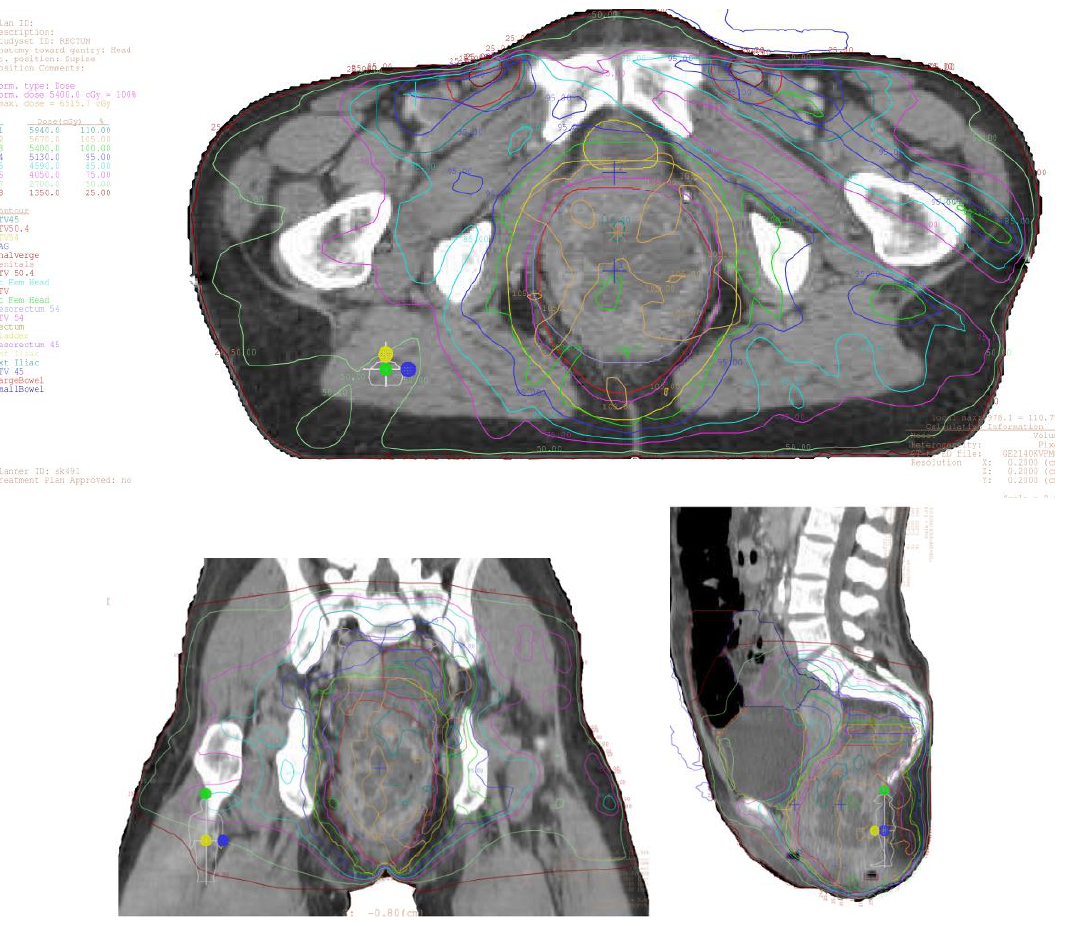
Figure 1. Example of 3DCRT photon plan for a patient with localized anal cancer. The primary tumor involved lymph nodes, and elective nodes were treated to 54 Gy, 50.4 Gy, and 45 Gy in 30 fractions, respectively.